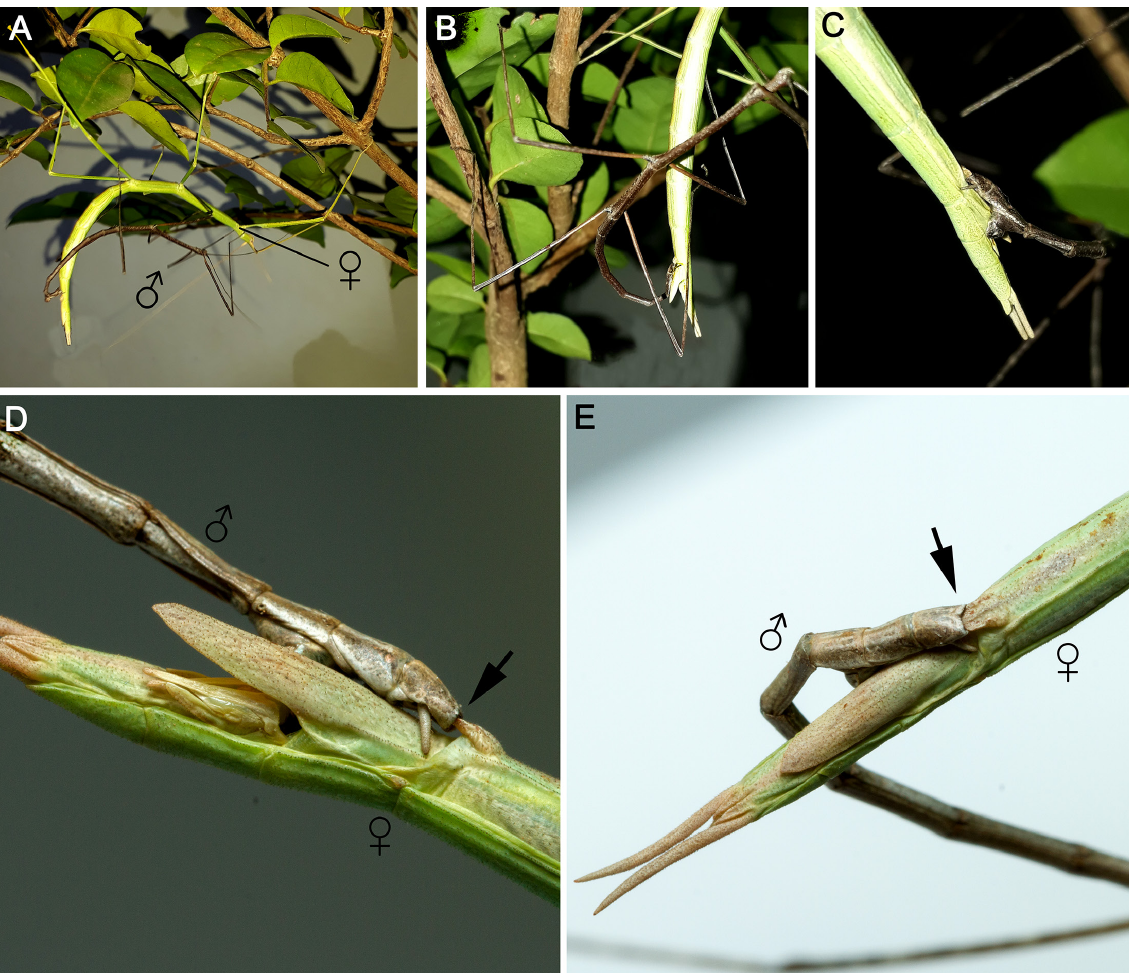
Fig. 45. Arumatia motenata Ghirotto gen. et sp. nov., sexual behaviour and mating attachment mechanism, from Serra do Cipó, Minas Gerais, Brazil. A–C . Sequential copulatory behaviour. D–E . Attachment